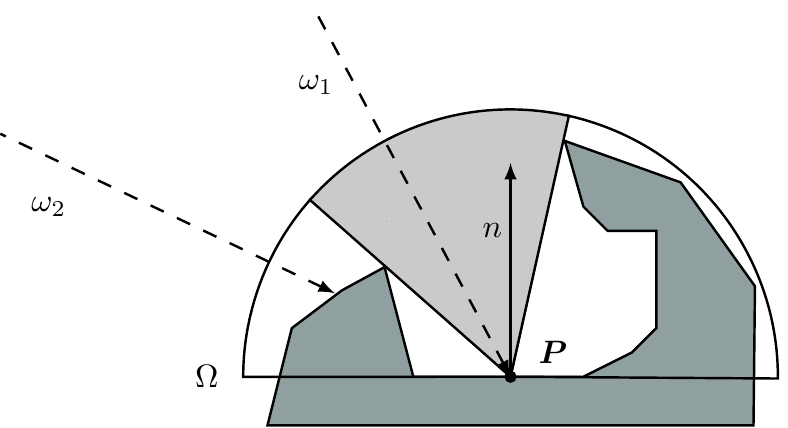
Figure 4. Visual representation of the ambient occlusion for a point P . For the rays in example, the function V ( P , ω ) has the following results: V ( P , ω 2 ) = 0, while V ( P , ω i ) = 1, area of the hemisphere Ω , in particular for ω 1